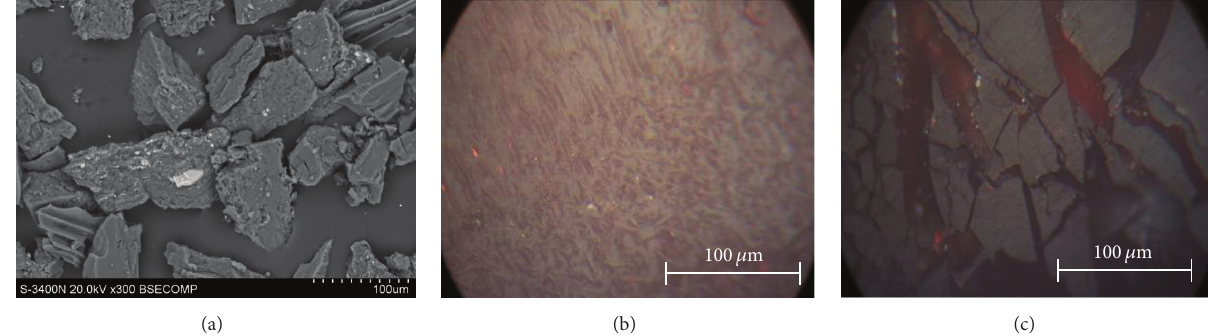
Figure 4: (a) SEM image of xyloid coal (scale = 100 𝜇 m), (b) reflection microscopic image of humotelinite (scale = 100 𝜇 m), and (c) reflection microscopic image of dehydrated fractures in humotelinite (scale = 100 𝜇 m). Table 3: N 2 cryogenic adsorption results of SLR-X and SLR-F.